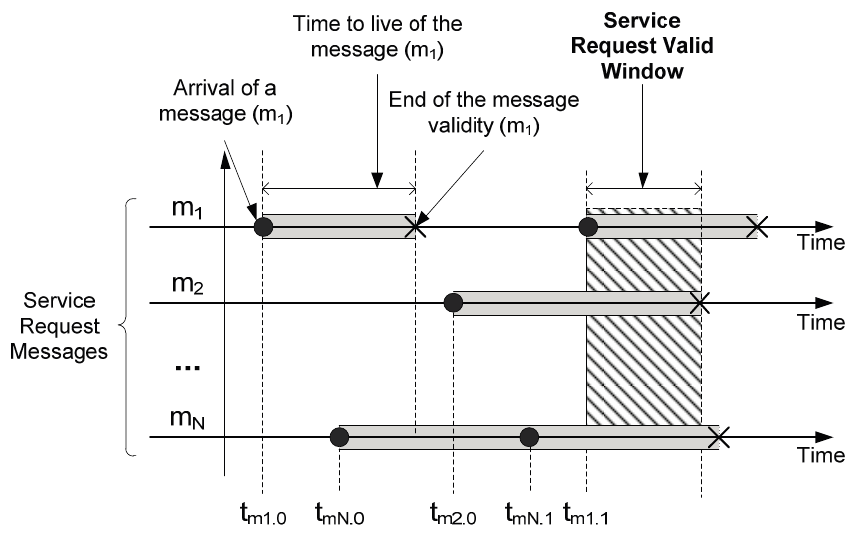
Figure 9. Message parameters used to characterize the internal QoS parameters.